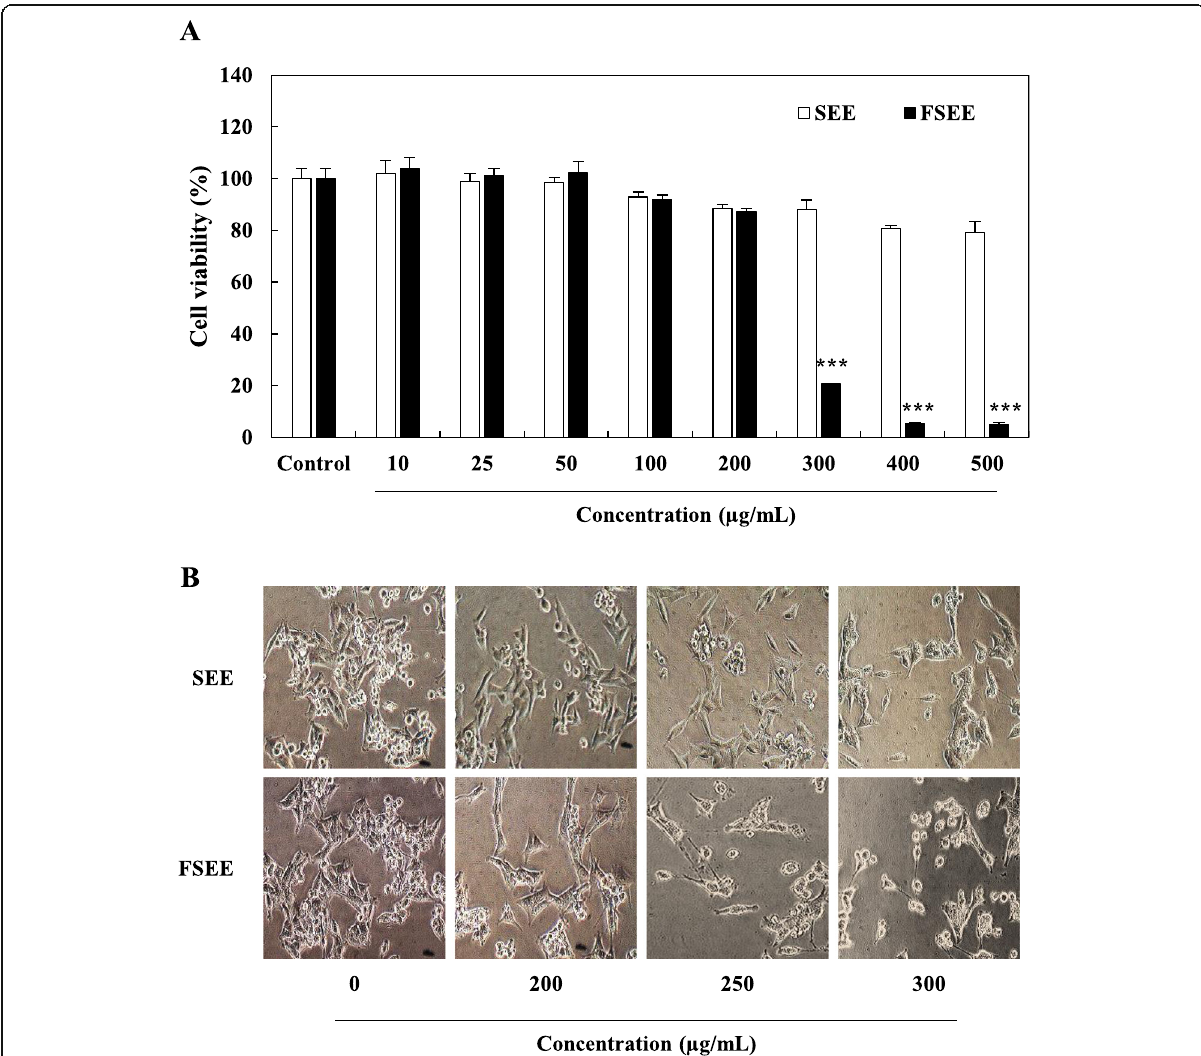
Fig. 1 Cell growth inhibitory effects on HepG2 hepatocellular carcinoma cells treated with silkworm larva ethanol extract (SEE), and fermented silkworm larva ethanol extract (FSEE) for 24 h. a Cell viability was measured by SRB assay. Data values were expressed as mean ± SD of triplicate determinations. Significant differences were compared with the control at * p < 0.05, ** p < 0.01, and *** p < 0.001 using one-way ANOVA. b